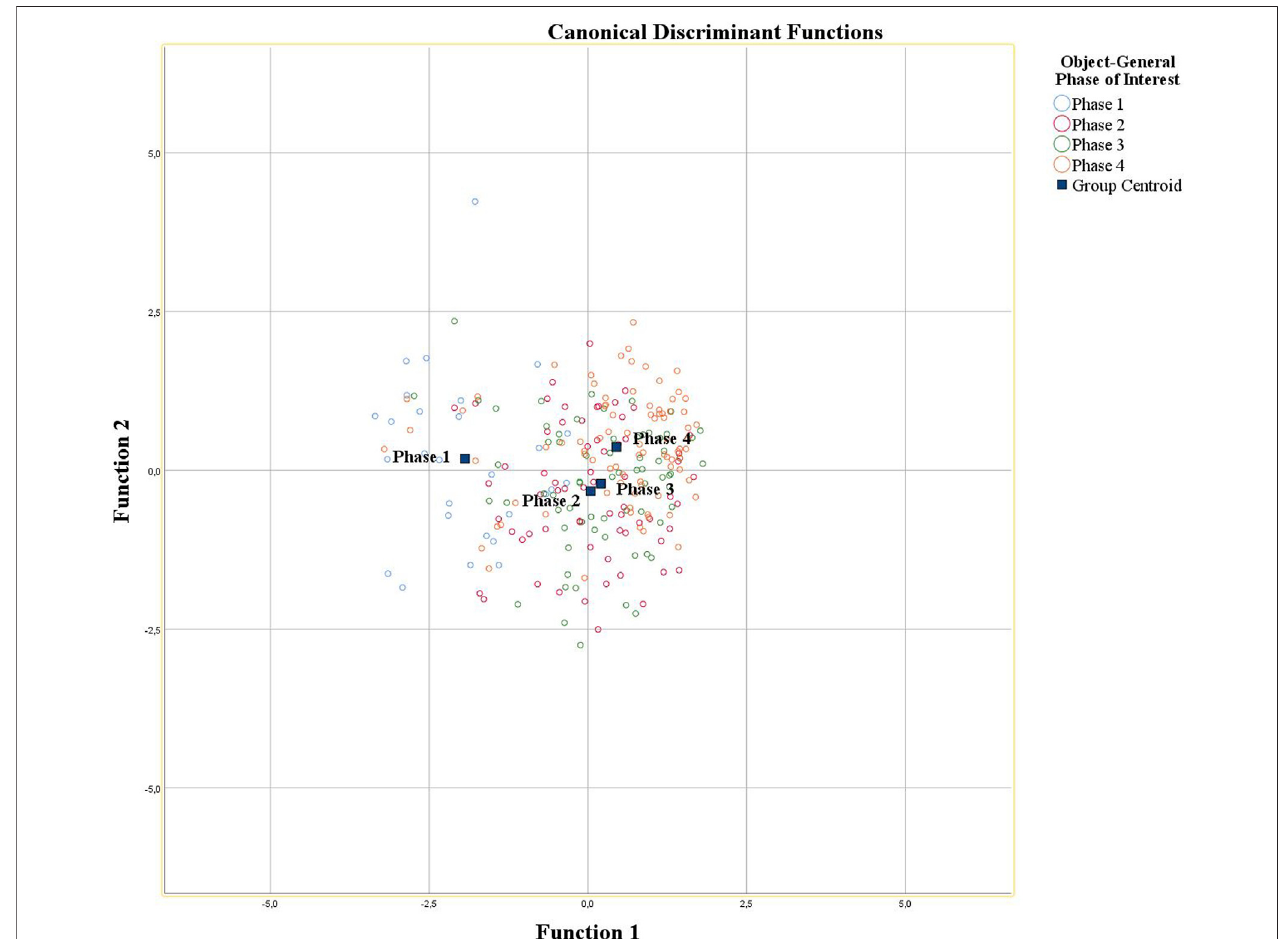
FIGURE 2 | Canonical discriminant functions 1 and 2 for interest in X, phases